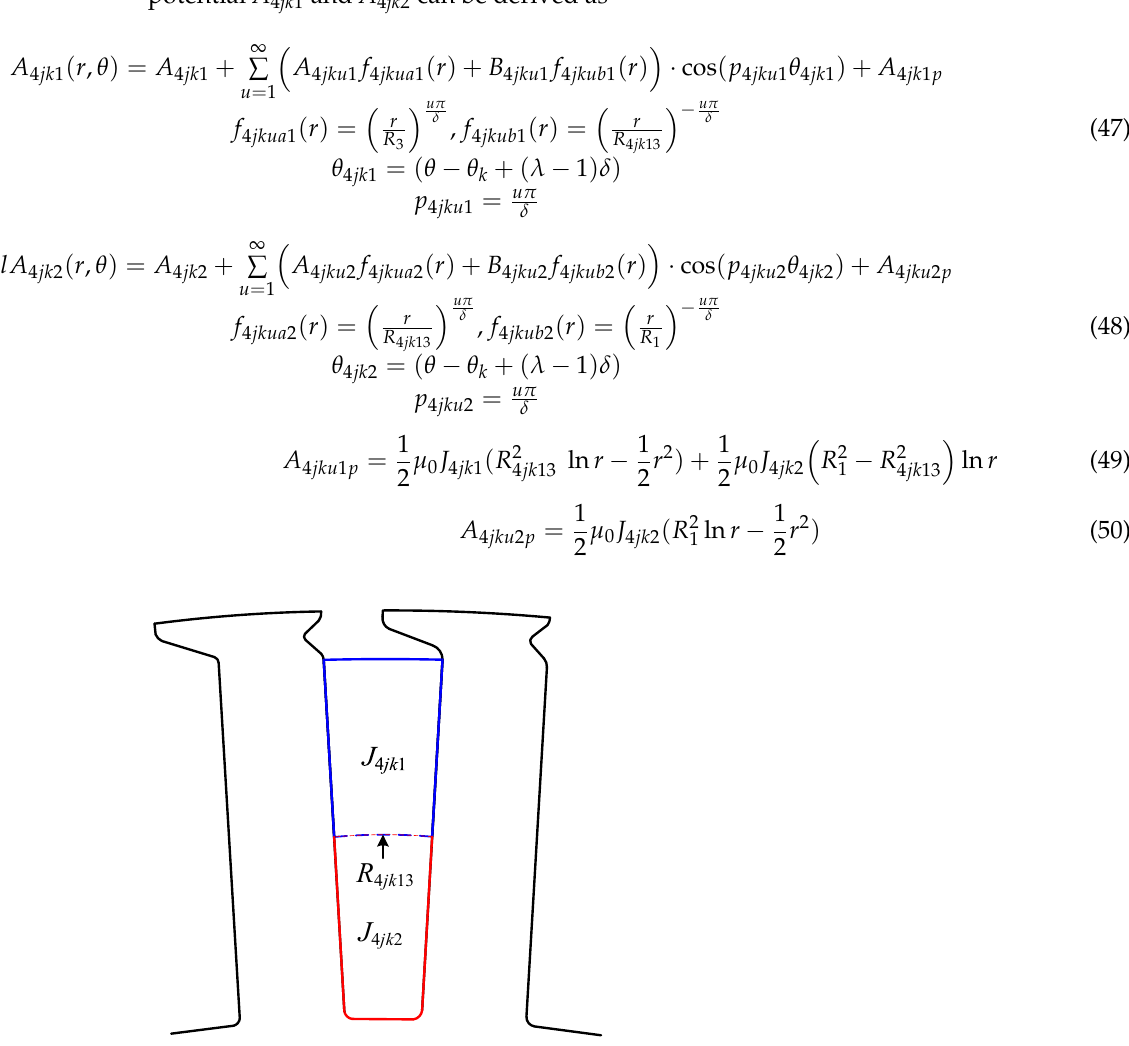
Figure 6. Winding configurations.